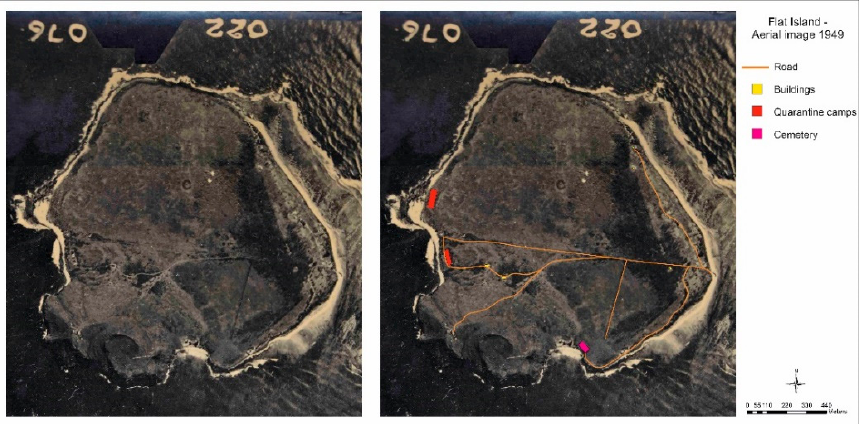
Figure 6. Georeferenced aerial image of Flat Island (1949, NCAP/ncap.org.uk, accessed on 17 February 2022) with the location of archaeological features.